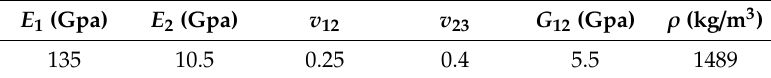
Table 2. Material properties of the CFRP plate.